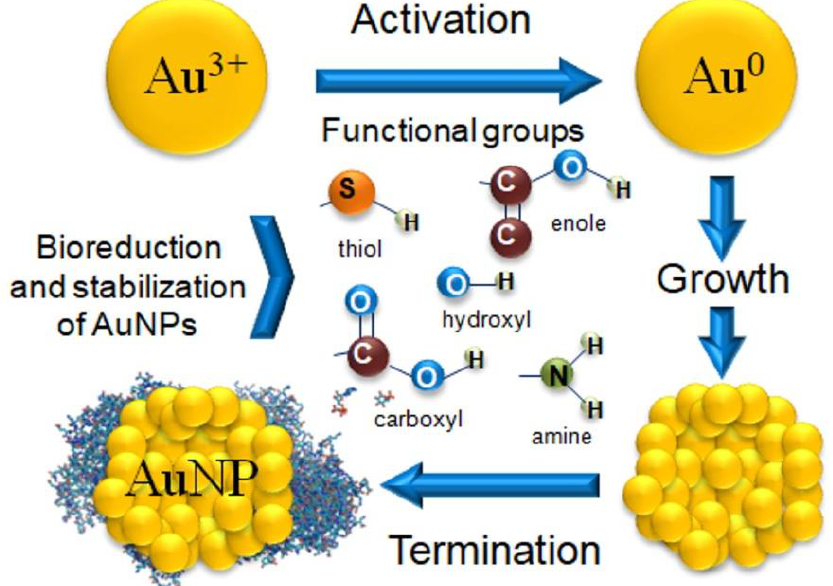
Figure 2. Mechanism of AuNPs biosynthesis and functional groups involved in the reduction of gold ions and stabilization of AuNPs.